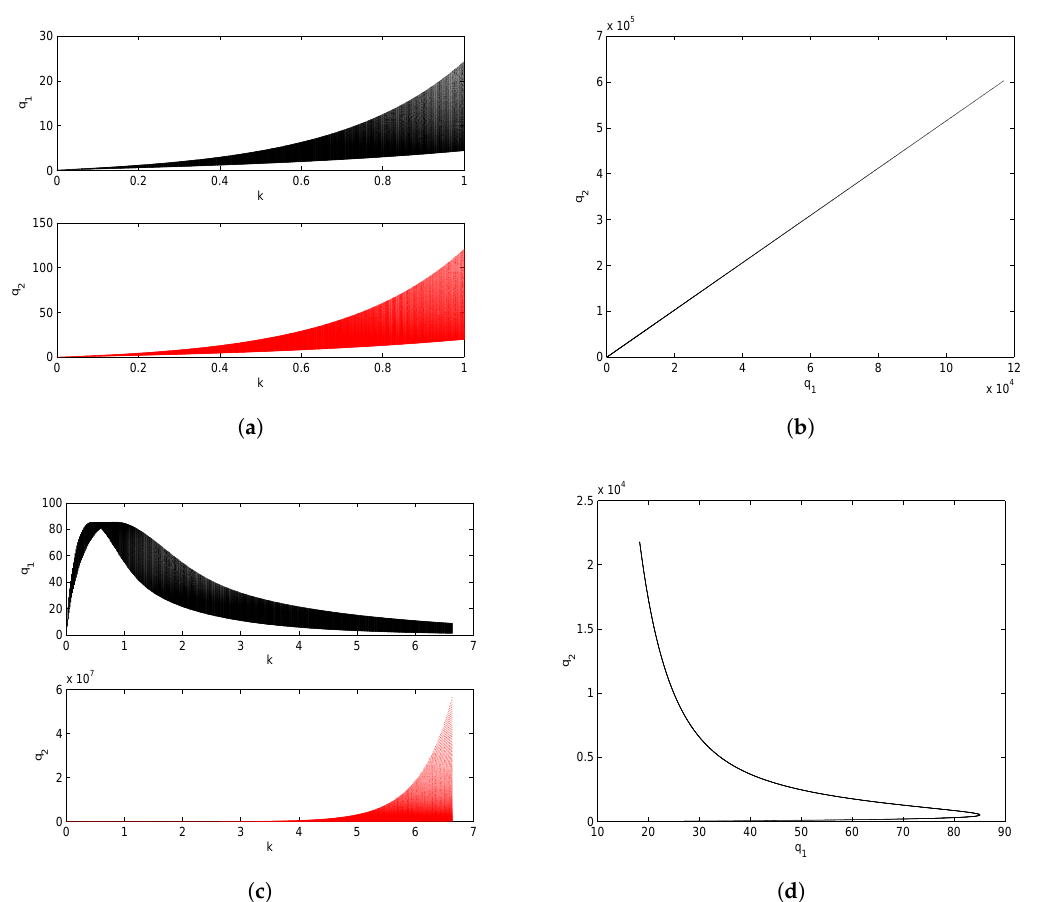
Figure 9. ( a ) bifurcation diagram when varying the parameter k ; ( b ) the phase portrait at α = 0.03, β = 0.01, c = 0.005, k = 0.13; ( c ) bifurcation diagram when varying the parameter k ; ( d ) the phase portrait at α = 0.3, β = 0.1, c = 0.003, k =